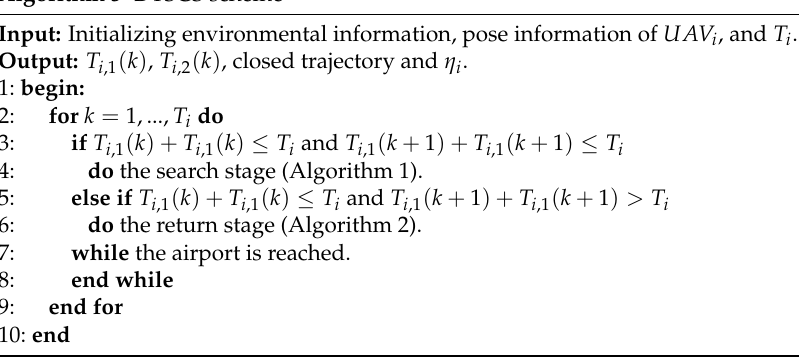
Figure 5. Cause for the remaining range. Algorithm 3 DTSCS